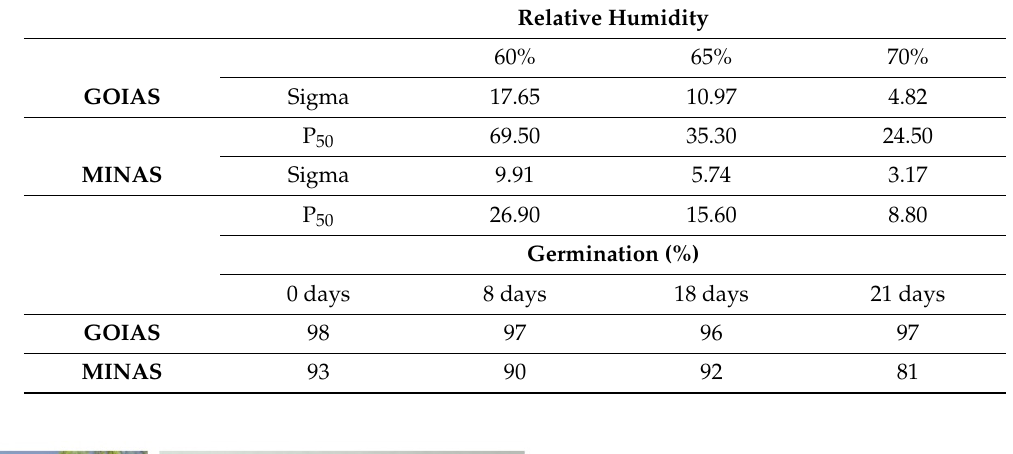
Table 1. Seed longevity upon ageing at 45 ◦ C and at different relative humidities; and germination after 0, 8, 18 and 21 days of ageing at 45 ◦ C and 60% RH. Sigma and P 50 values in days.